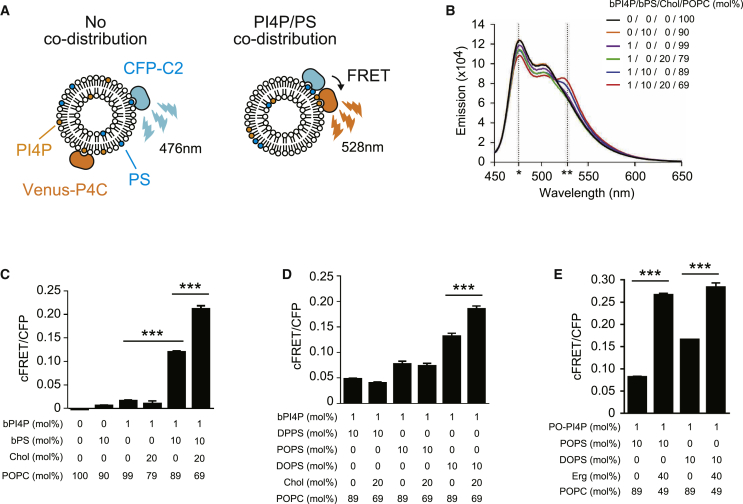
Co-distribution of Unsaturated PS and PI4P in the Presence of Sterols In Vitro(A) The in vitro FRET assay to detect PI4P and PS co-distribution on liposomes. Corrected FRET (cFRET) was calculated as described in STAR Methods.(B) Emission spectrum of Venus-P4C (PI4P probe) and CFP-C2Lact (PS probe) in vitro, as described in STAR Methods. The x and y axis indicate wavelength and intensity of emission fluorescence, respectively. Note that FRET signal was increased in the presence of both brain phosphatidylserine (bPS) and cholesterol (Chol). Asterisks indicate positions of emission maximum of CFP at 476 nm (∗) and FRET at 528 nm (∗∗).(C) FRET toward liposomes either lacking or containing 1 mol% bPI4P, bPS, and/or cholesterol (Chol) as indicated.(D) FRET toward 1 mol% bPI4P liposomes containing the indicated PS species either lacking or containing Chol.(E) FRET toward 1 mol% PO-PI4P liposomes containing the indicated PS species either lacking or containing ergosterol (Erg). Data represent mean ± SEM (n = 3).∗∗∗p < 0.001. See also Figure S5.